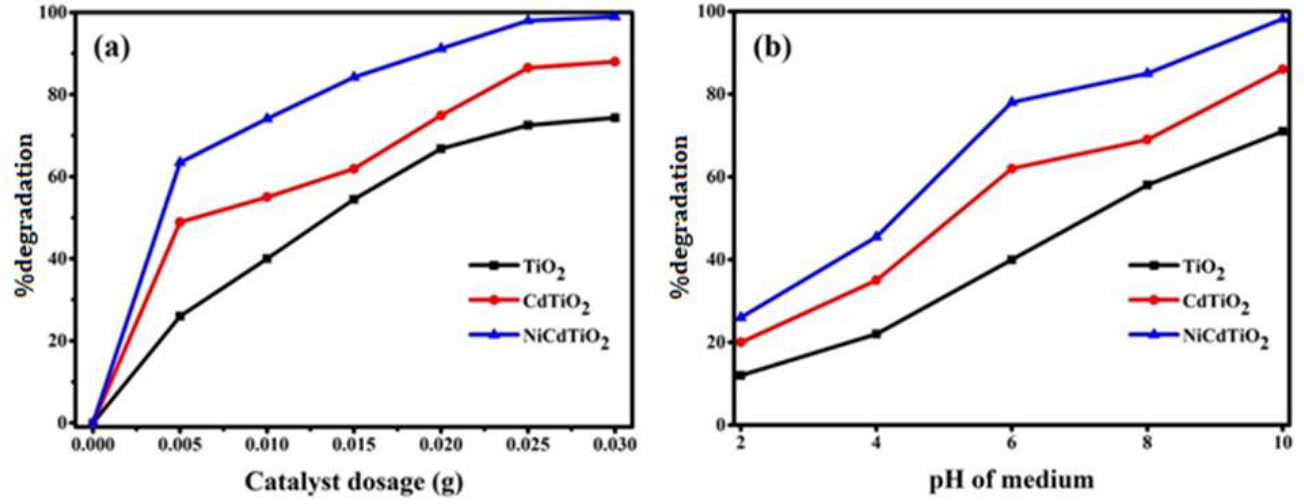
Figure 15. %degradation of MG dye photodegradation ( a ) by different dosage of photocatalysts and ( b ) at different pH.